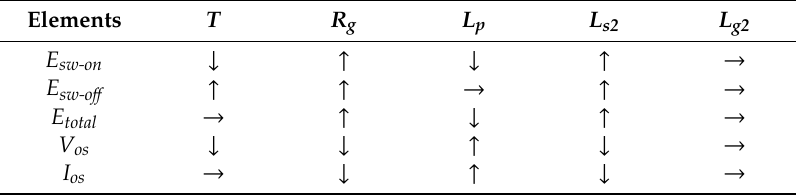
Table 6. Quantitative comparison of loss, voltage and current